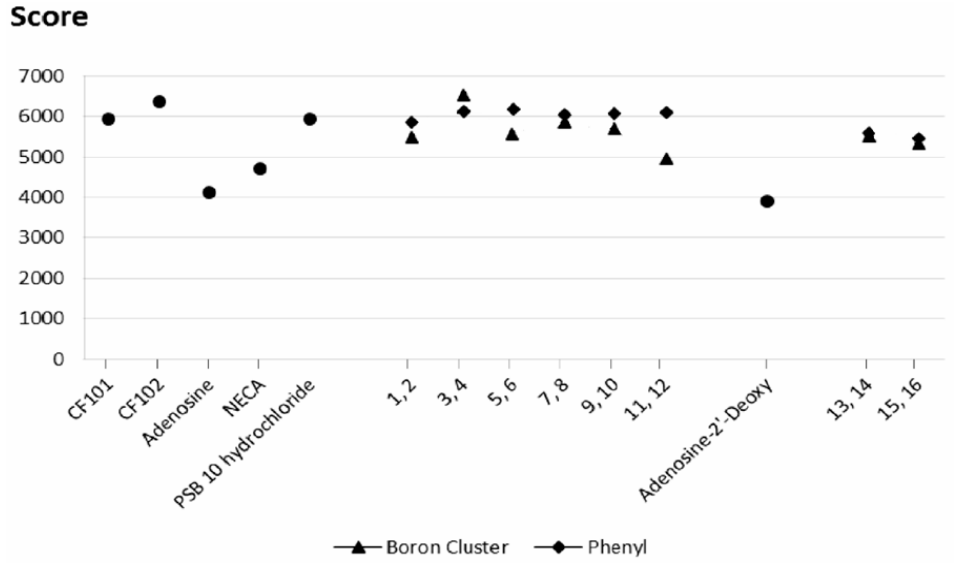
Figure 7. Geometric scores for the ligand shape complementarity to the A3 receptor. reference molecules (CF101, CF102, adenosine, 2 ′ -deoxyadenosine, NECA and PSB 10 hydrochloride); molecules bearing a boron cluster ( 1 , 3 , 5 , 7 , 9 , 11 , 13 , 15 ); ligands with a phenyl group ( 2 , 4 , 6 , 8 , 10 , 12 , 14 , 16 ) .